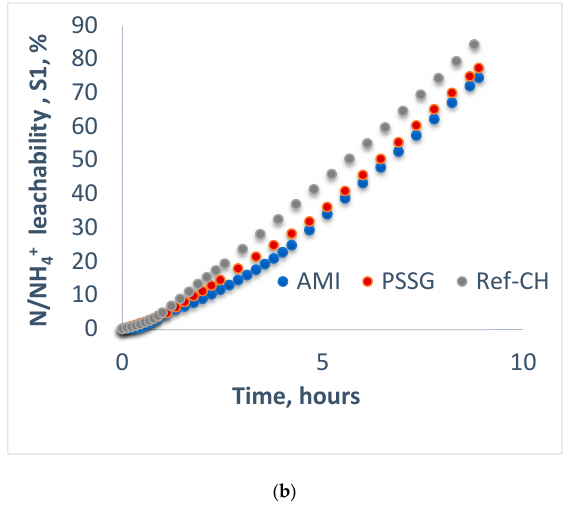
Figure 3. Fractions of ammonium adsorbed ( a ) and leached ( b ) for the fertilizers on the mixture of sand and soil S1 ‐ L.